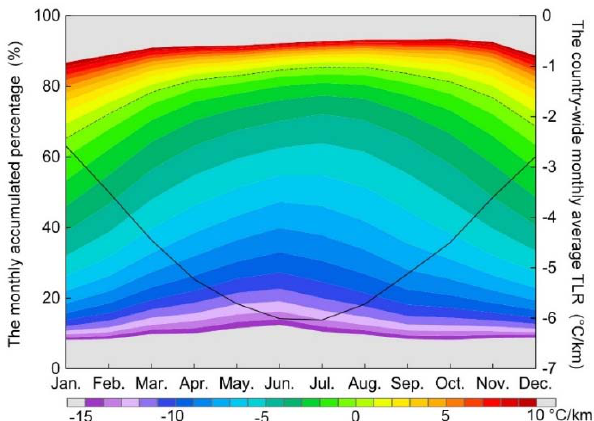
Figure 7. Variation of monthly accumulated percentage at each level of the TLR and the country-wide monthly average TLR. The primary Y-axis represents the accumulated percentage of image pixels at each level; the secondary Y-axis represents the country-averaged monthly average TLR. The dashed line is the dividing line between levels of Γ ≤ 0 and Γ > 0 °C/km. The solid line is the mean of the monthly average TLR of the image pixels, where - 15 < Γ ≤ 10 °C/km.